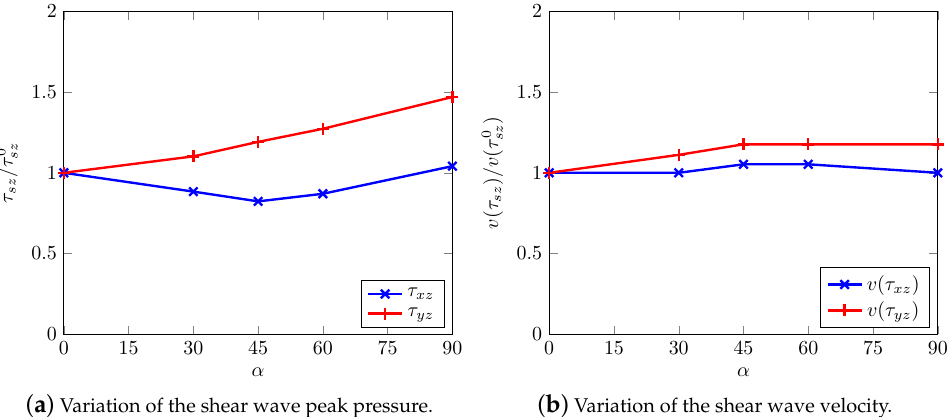
( b ) Variation of the shear wave velocity. Figure 16. Shear wave splitting along the horizontal axis. Table 4. Intrinsic transversely isotropic model: material parameters.